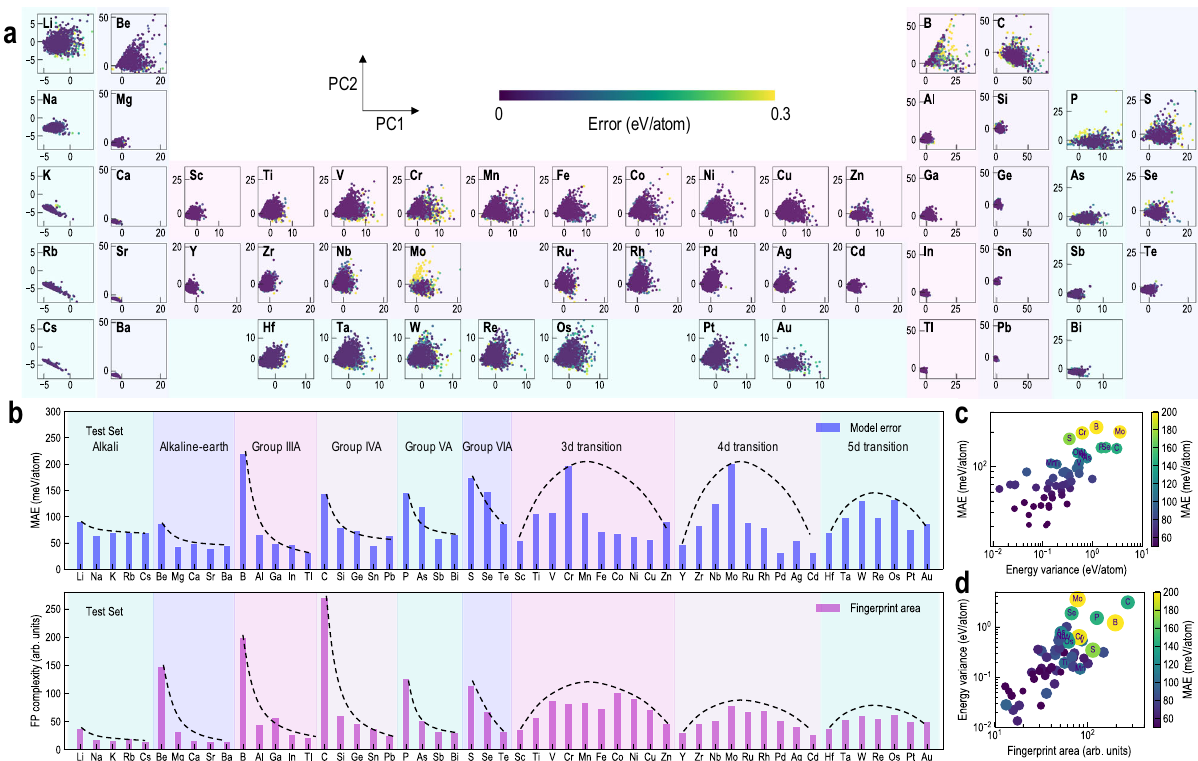
Fig. 3 Trends in model prediction errors with structural diversity of the element. a SOAP fi ngerprint representation of clusters across different elements as projected along with the fi rst two principal components (PCs). The area covered by an element in the PC space is proportional to its structural diversity, and thus, the dif fi culty to train an accurate potential model. Also, the structural diversity of an element is closely related to its position in the periodic table. Regions of higher errors mostly occur at the boundary of the PC space which are expected to belong to under-represented con fi gurations. b Trend in the prediction errors for different elements when grouped across different columns or rows of the periodic table. A similar trend can be seen for the elemental PC area, suggesting that elemental structural diversity correlates well with the model errors. The dotted lines capture the approximate trend within a group of elements and guide the eye. c Correlation between the prediction error and the inverse of the smoothness of the element energy surface. d Elements with high prediction errors display either high structural diversity or exhibit highly corrugated energy surfaces. Elements with mean absolute error (MAE) >100 meV/atom have been marked in c and d